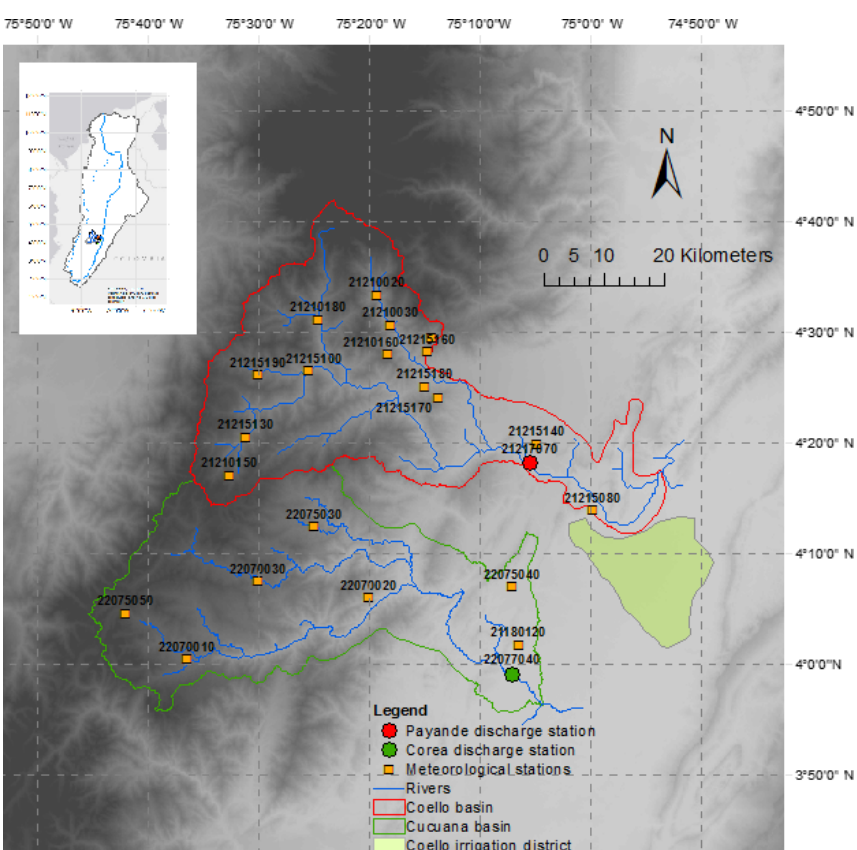
Figure 2. Map of the Coello and Cucuana river basins and the Coello irrigation district, and their location in the Magdalena macro-basin in Colombia. The points indicate discharge stations and the squares indicate meteorological stations.